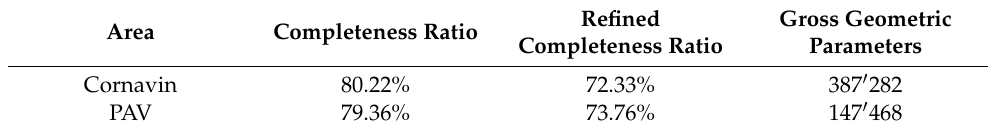
Table 5. Description of data completeness ratios for PAV and Cornavin